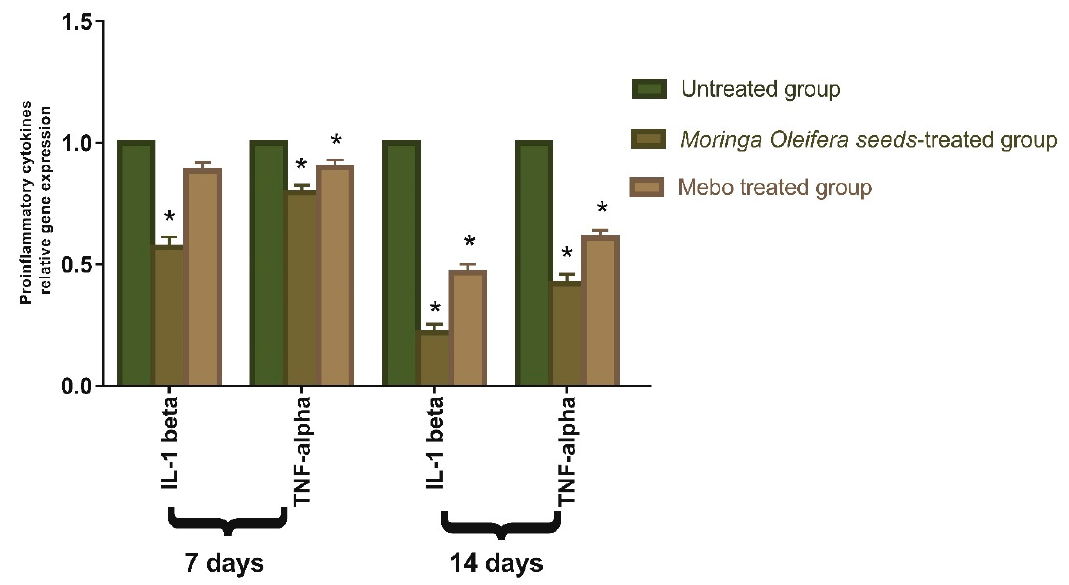
Figure 5. Gene expression in injured tissues of rabbits from various groups after normalizing to glyceraldehyde 3-phosphate dehydrogenase (GAPDH). The bars reflect the mean ± SD. A two-way ANOVA test is used to determine whether there is a significant difference between groups where: * p < 0.001 compared to those of the group left without treatment on that particular day.